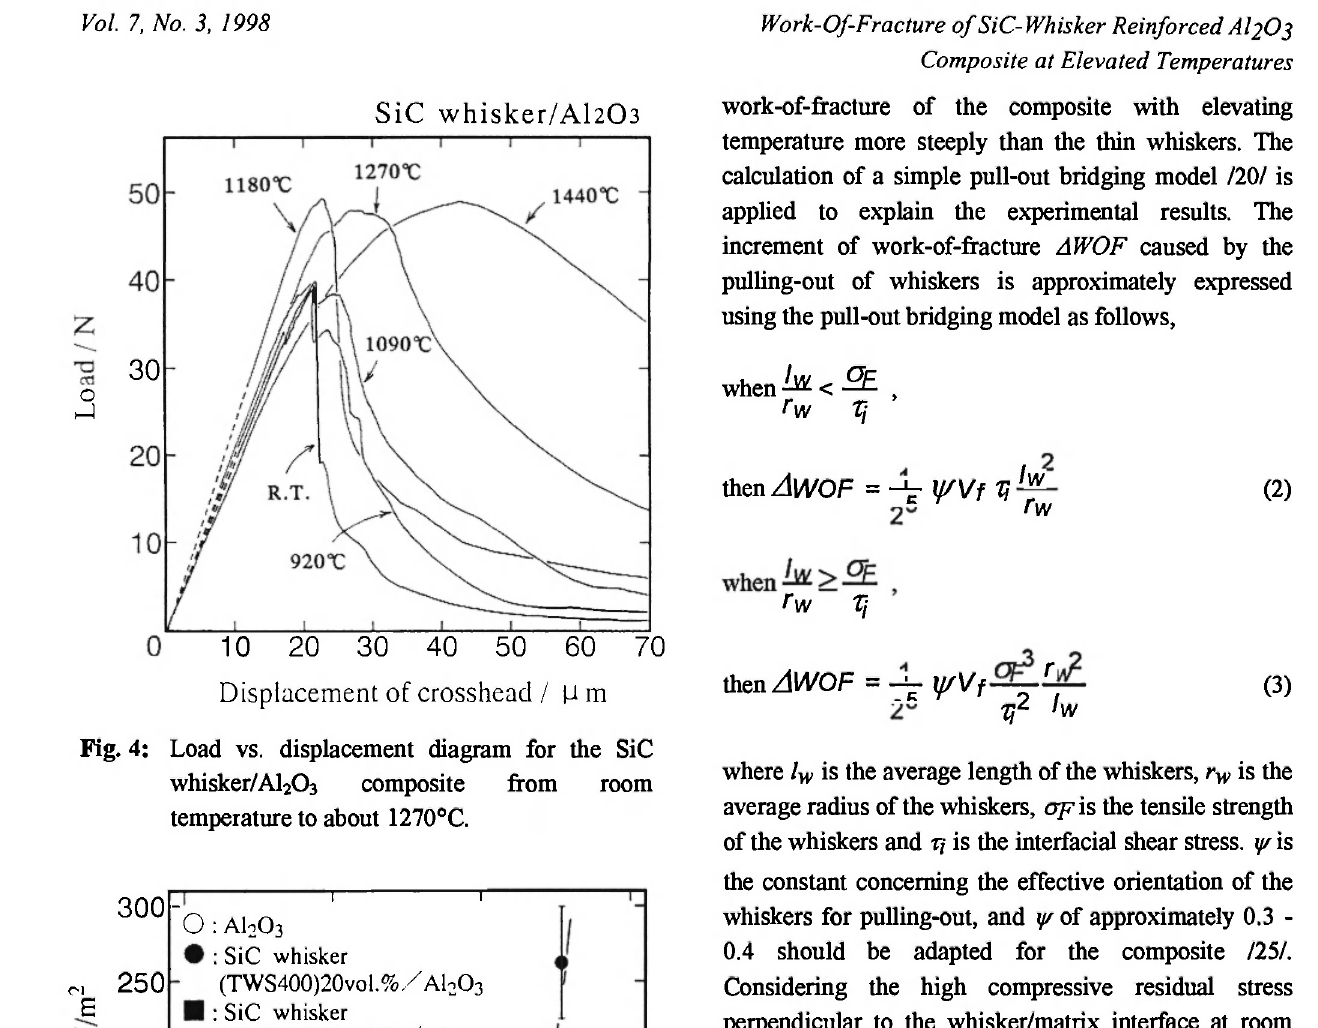
Fig. 4: Load vs. displacement diagram for the SiC whisker/Al 03 composite from room 2 temperature to about 1270°C.